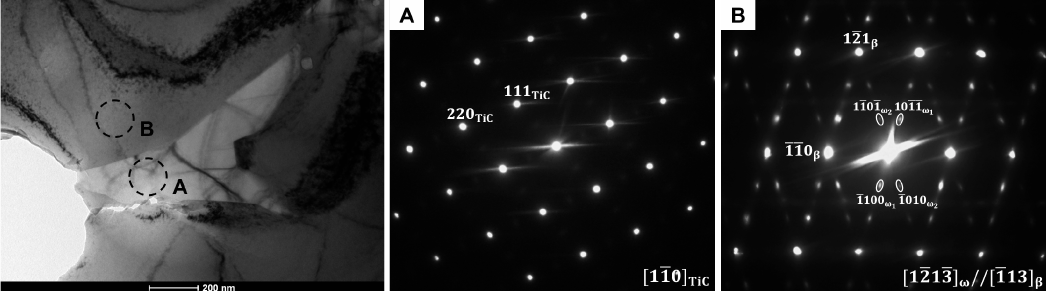
Figure 5. BF/TEM micrograph of Ti-14Nb-2Mo alloy presenting the precipitation occurred at the grain boundary with the corresponding SADPs (A and B correspond to the areas marked by the circles).